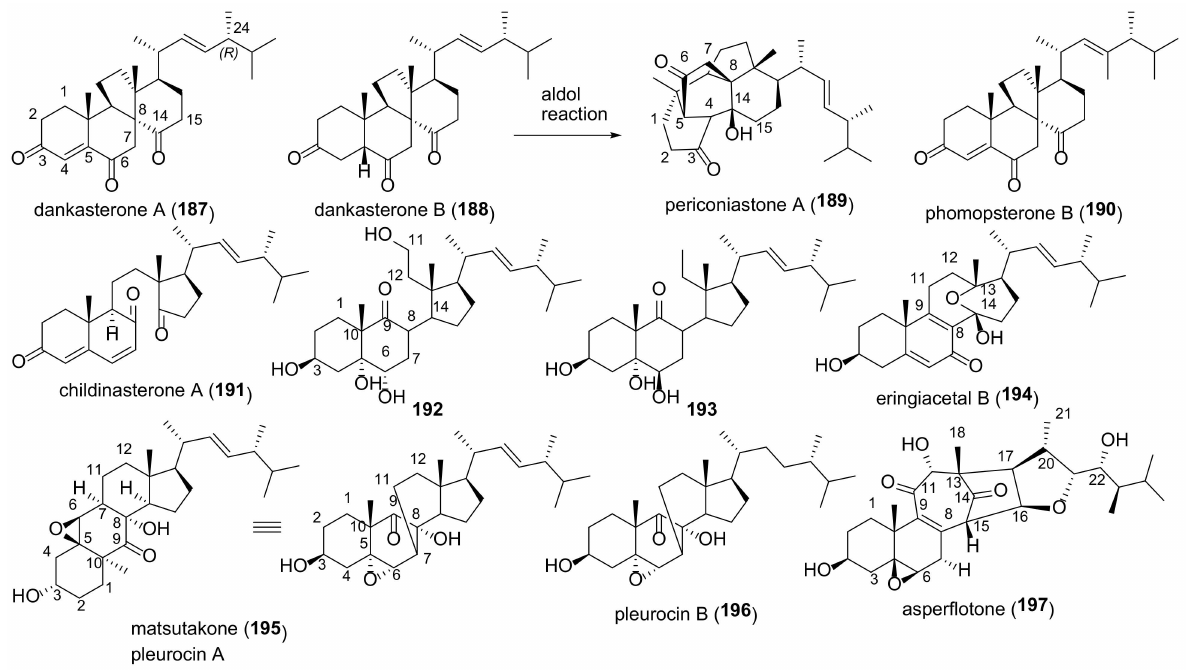
Figure 20. Structures of ergostanes with a rearranged